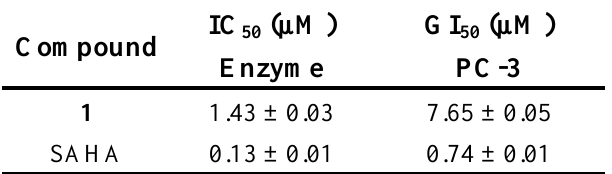
Table 1 . HDAC enzyme and growth inhibition by sulfur compound 1 and